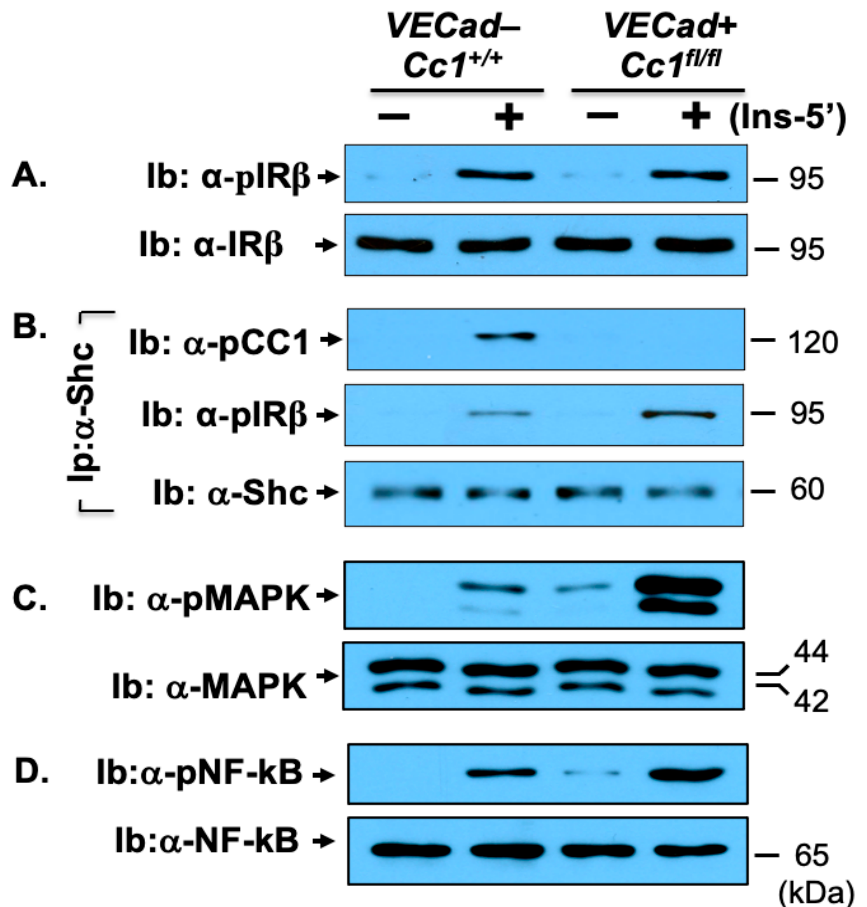
Figure 4. NF- κ B insulin signaling pathway in liver endothelial cells. Primary liver endothelial cells (LEC) from 2-month-old male WT ( VECad − Cc1 +/+ ) and null ( VECad+Cc1 fl/fl ) mice were treated with (Ins, 100 nM) or without insulin for 5 min before their lysates were subjected to immunblotting (Ib) with antibody against ( A ) phospho-IR β ( α -pIR β ), ( C ) phopsho-MAP kinase ( α -pMAPK) and ( D ) phopho-NF- κ B ( α -pNF- κ B) and in parallel gels, with their specific antibodies for normalization. ( B ) lysates were subjected to immunoprecipitation (Ip) with Shc antibody followed by immunoblotting (Ib) with antibodies against phospho-CEACAM1 (pCC1) and IR β or Shc to assess the amount of pCC1 and pIR β in the Shc immunopellet. Gels represent two separate experiments.